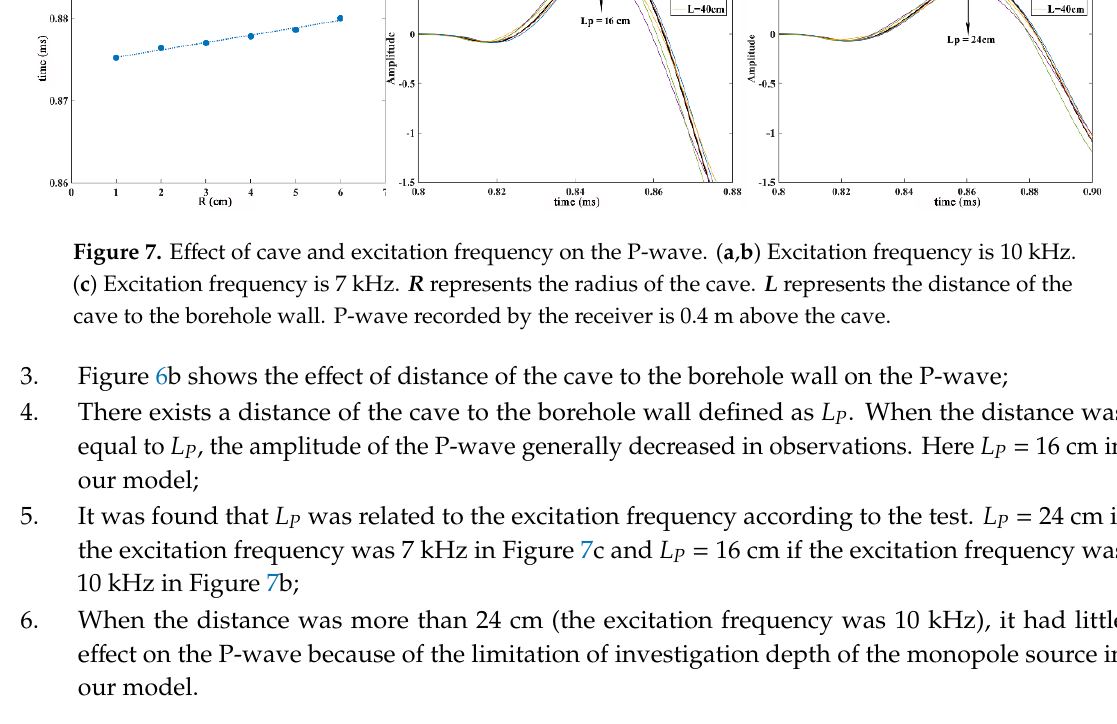
Figure 6. Effect of the cave on P-wave. ( a) shows the effect of the cave radius on P-wave. ( b) shows the effect of the cave position on P-wave. R represents the radius of the cave. L represents the distance of the cave to the borehole wall. Center frequency of source is 10 kHz. P-wave recorded by the receiver is 0.4 m above the cave.